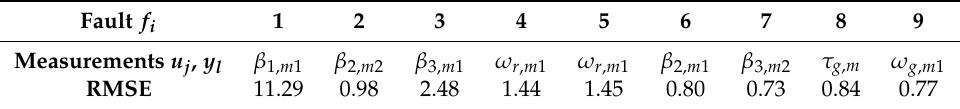
Table 2. The most sensitive measurements u j ( k ) and y l ( k ) and their RMSE values with respect to the fault f i ( k )